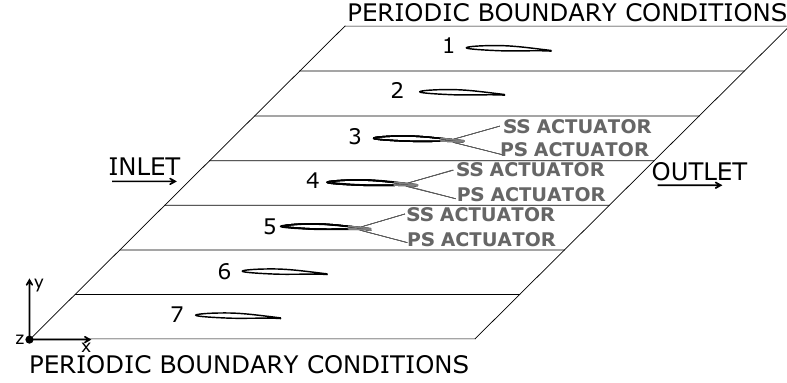
Figure 1. Sketch of the computational geometry for the blade